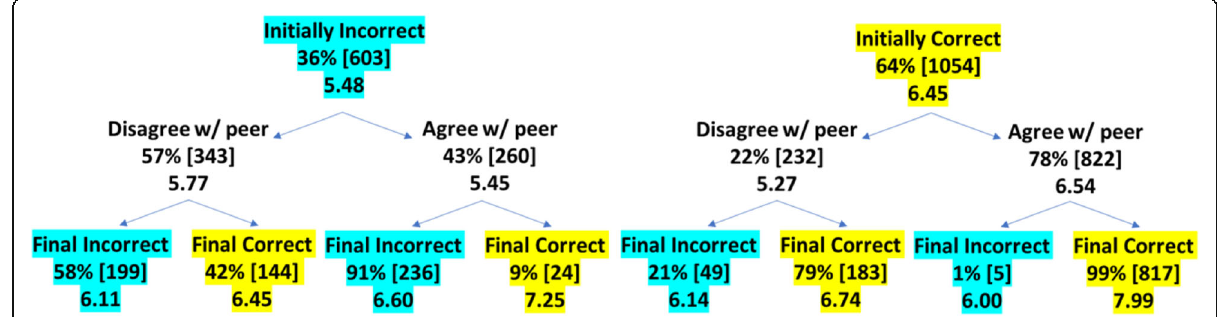
Fig. 2 The pathways of answers from pre-discussion (top row) to post-discussion (bottom row). Percentages indicate the portion of items from the category immediately above in that category, the numbers in brackets indicate the raw numbers of items, and the numbers at the bottom of each entry indicate the confidence associated with those items. In the middle, white row, confidence values show the peer ’ s confidence. Turquoise indicates incorrect answers and yellow indicates correct answers